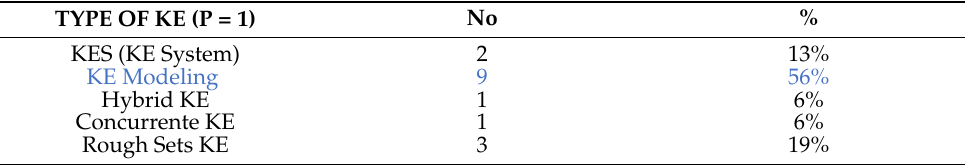
Table 6. Incidence of KE typology on articles that obtained a score of P =